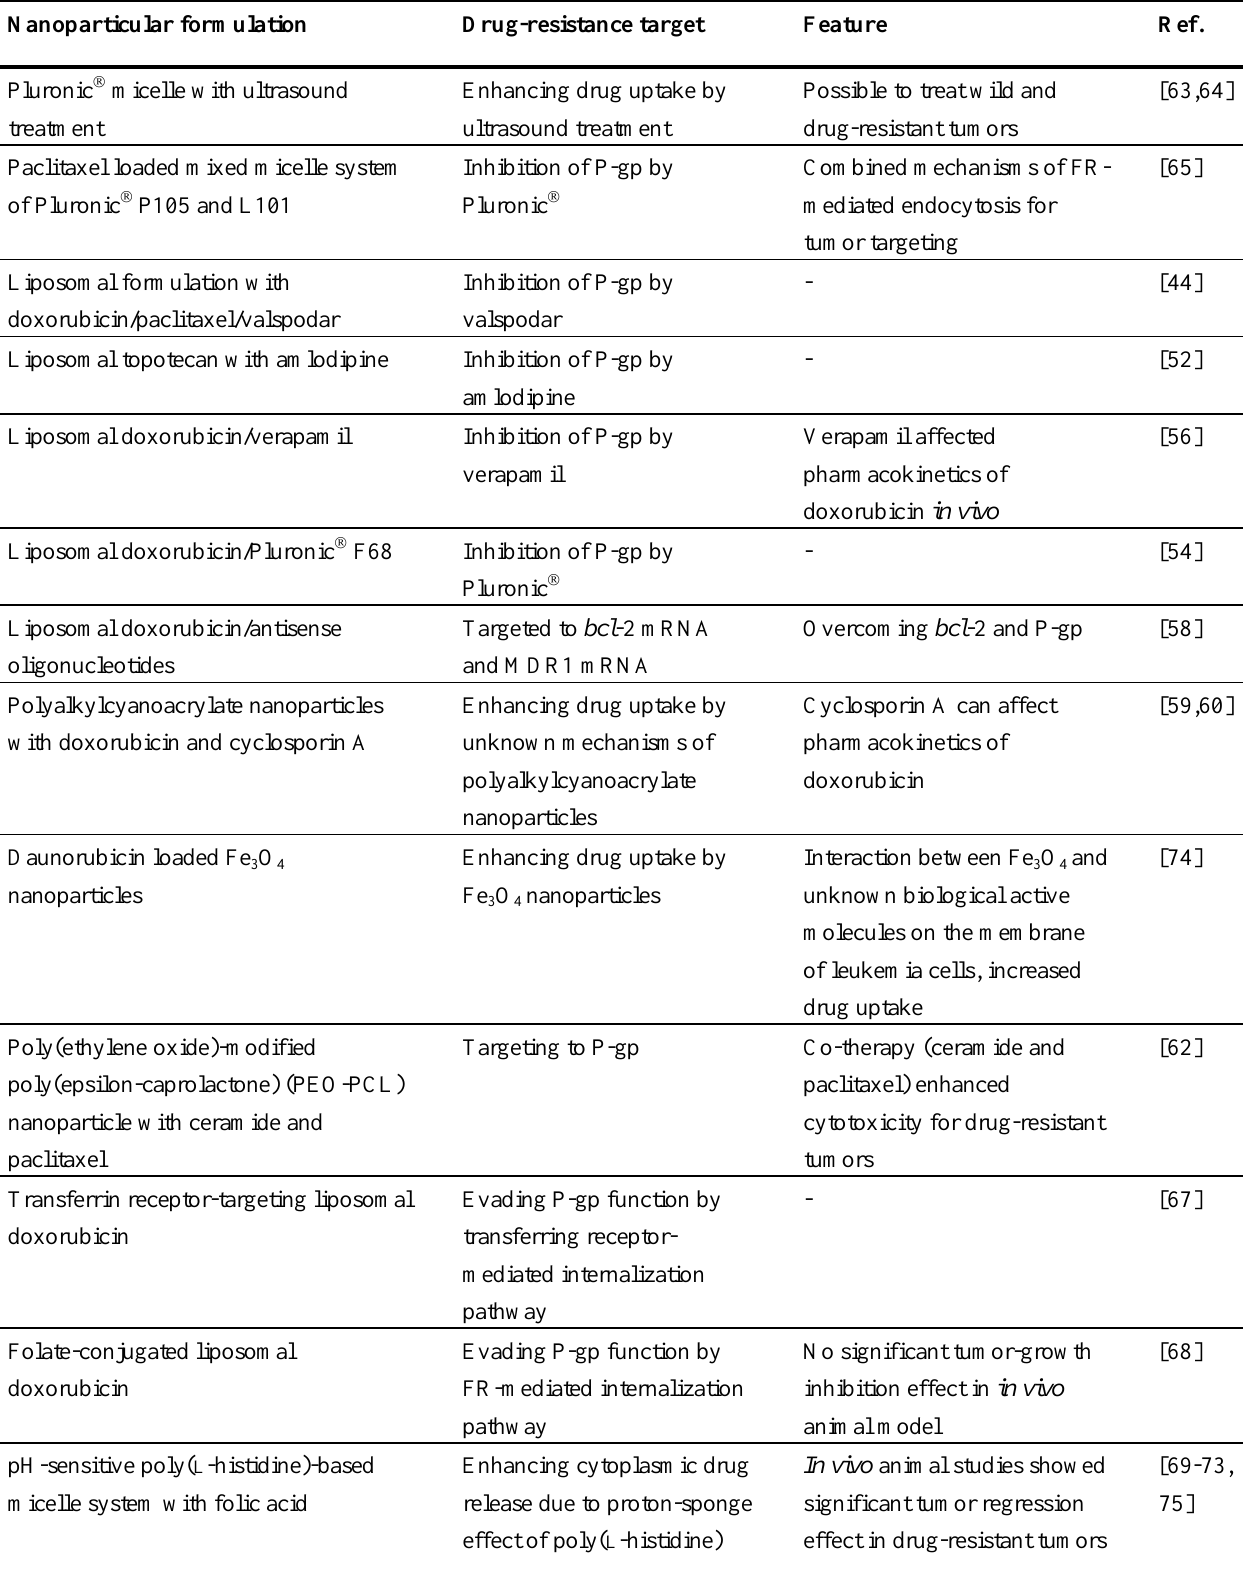
Table 1. Reversal of drug-resistance by nanoparticular